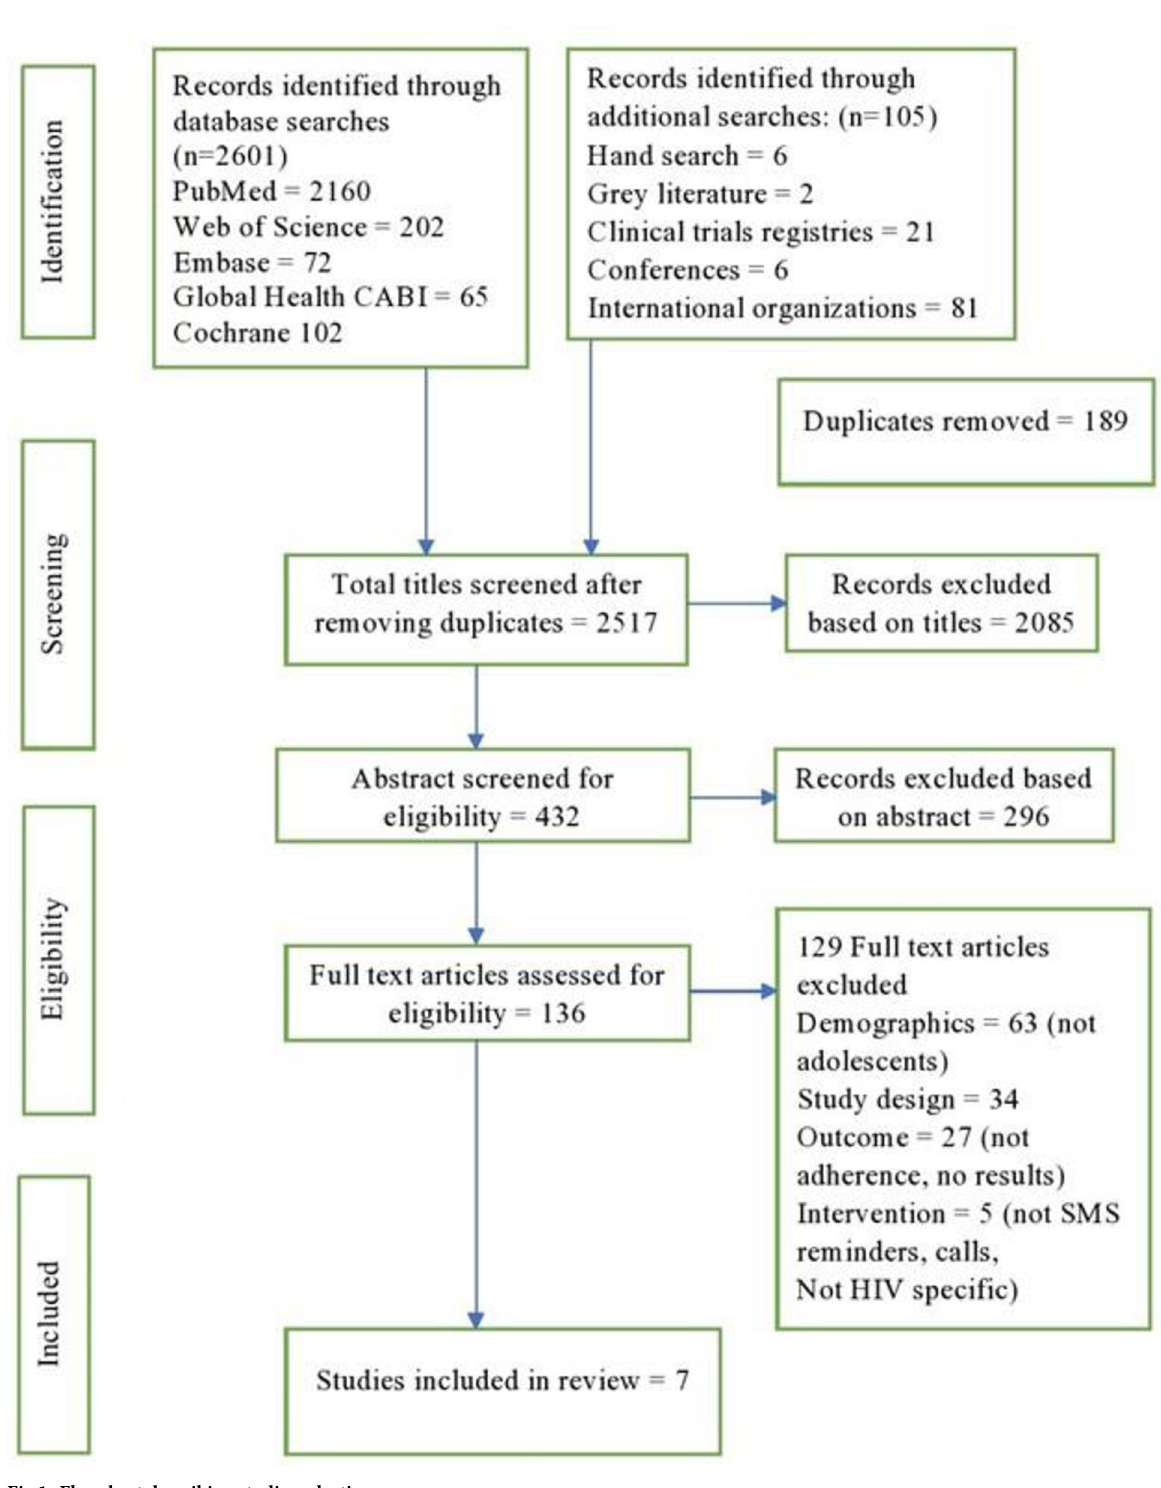
Fig 1. Flowchart describing studies selection process.